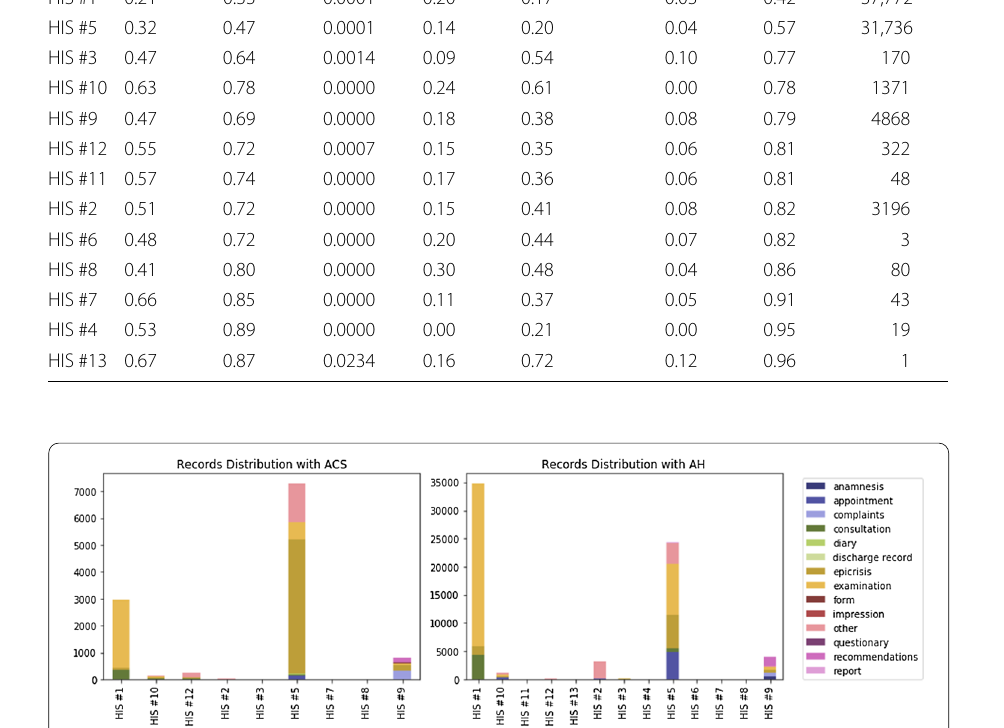
Fig. 8 Distributions of record types for patients with arterial hypertension (AH) and acute coronary syndrome (ACS) with manual